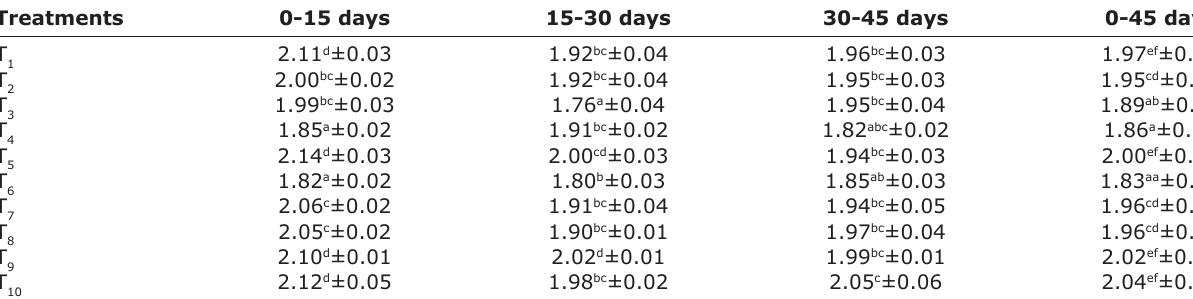
Table-7: FCR during different growth periods under dietary treatments.